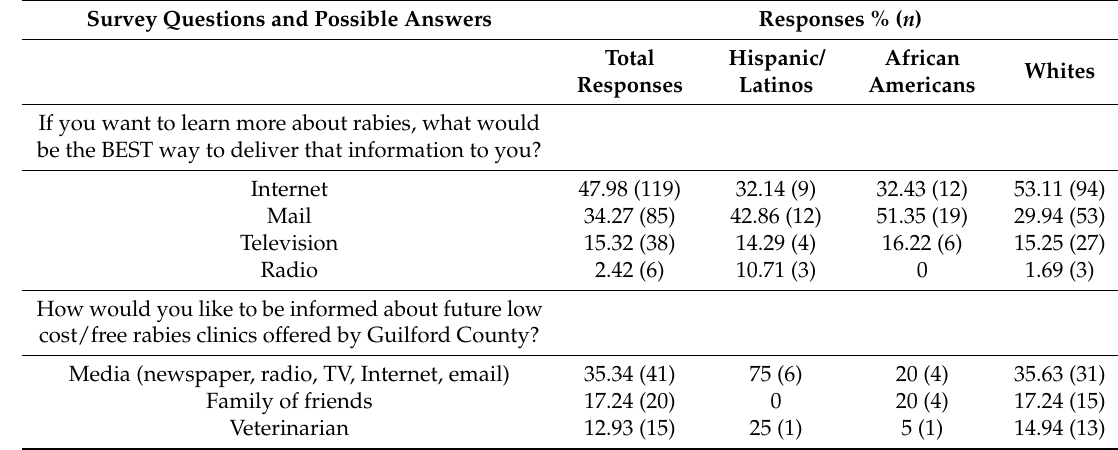
Table 3. Frequency of answers regarding rabies information outlet preference in Greensboro, North Carolina,